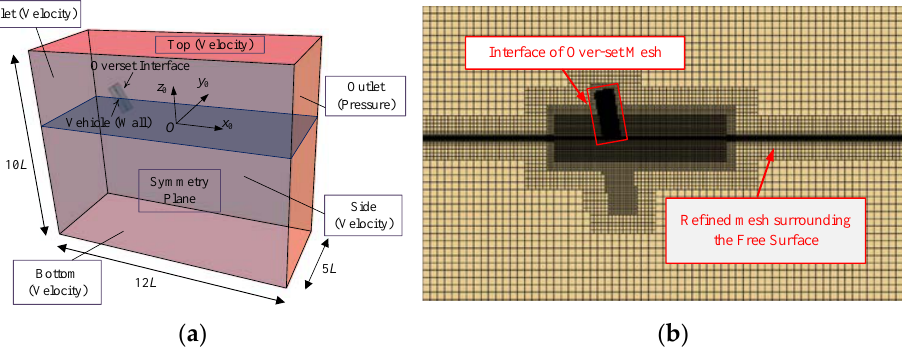
Figure 5. The sketch of CFD settings: ( a ) configuration of the boundary conditions; ( b ) mesh of computational domain.